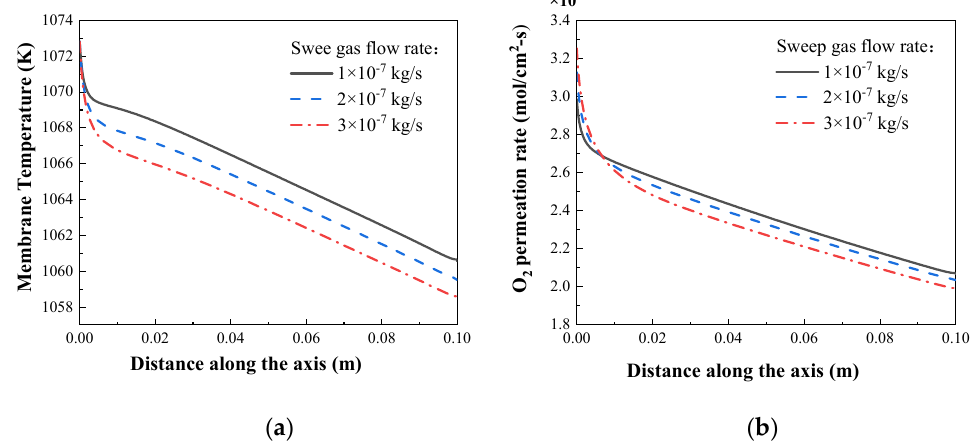
Figure 9. Effects of sweep gas flow rate on: ( a ) membrane temperature; ( b ) oxygen permeation rate.